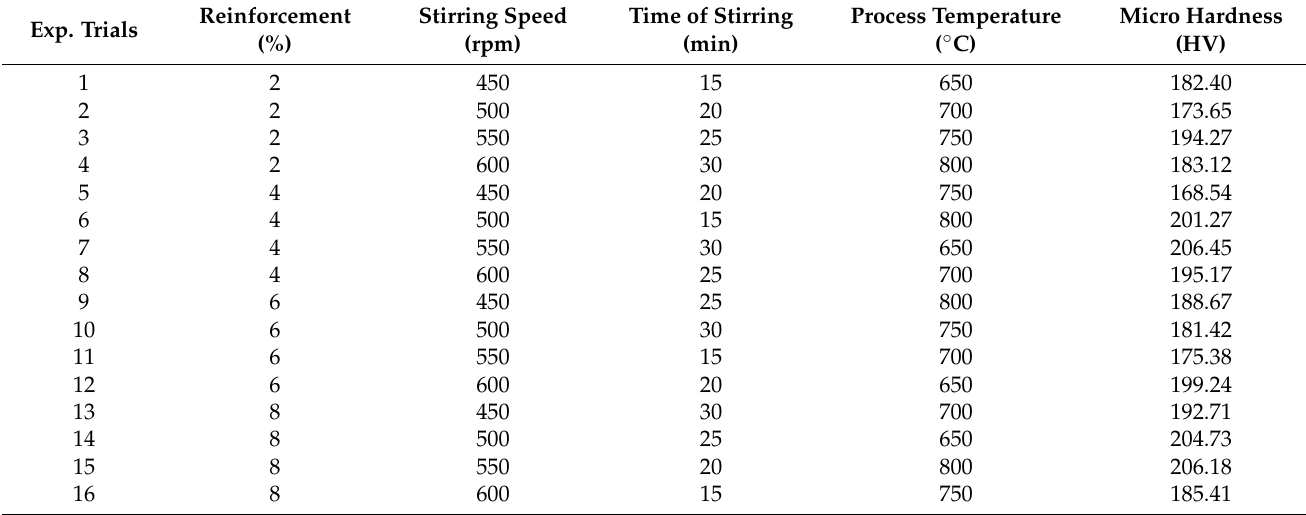
Table 11. Experimental summary of micro hardness.